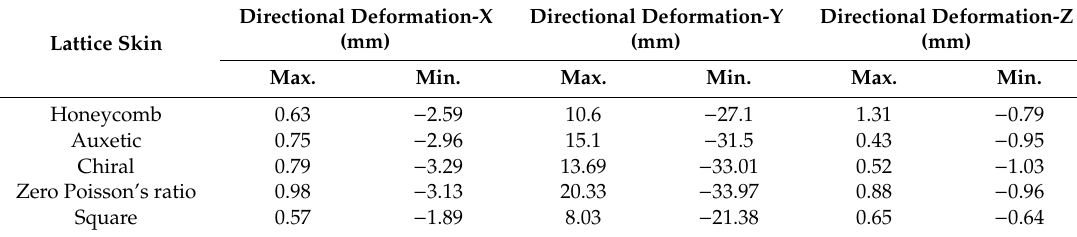
Table 4. Selected models’ directional deformation for the linear morphing case.